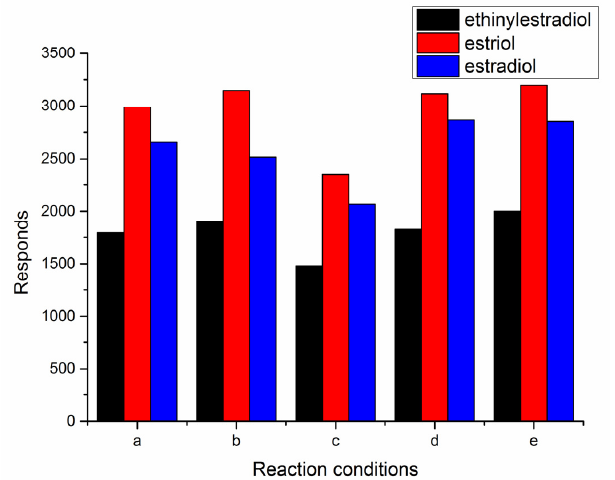
Figure 2. Influence of reaction conditions (a: without heat or ultrasound; b: heat for 10 min; c: heat for 20 min; d: ultrasound for 10 min; e: ultrasound for 20 min).